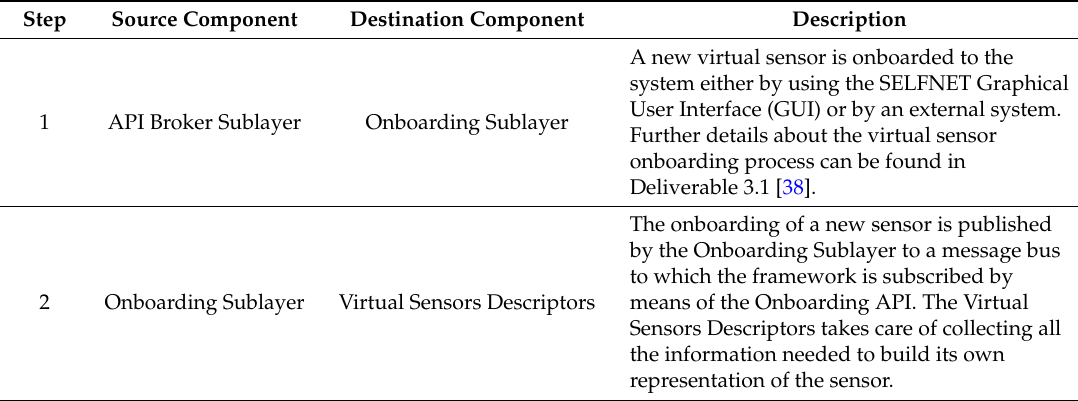
Table 5. Sensor Onboarding Workflow Steps.